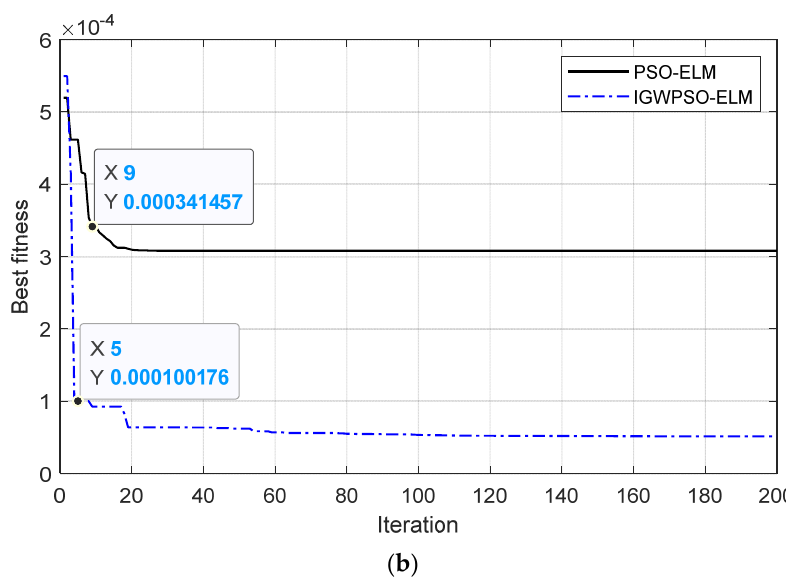
Figure 8. PSO-ELM vs. IGWPSO-ELM: (a) prediction results; (b) iterative process. Table 2. Comparison of the prediction accuracy between PSO-ELM and IGWPSO-ELM.